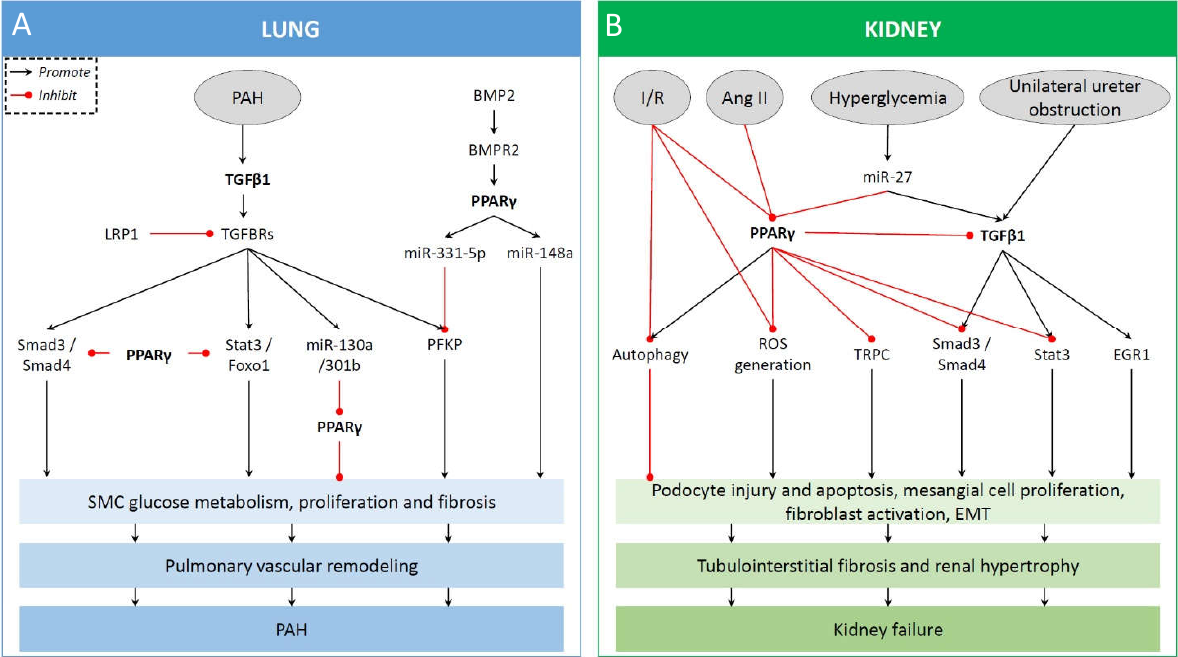
Figure 2. Summary of PPAR γ actions in pulmonary arterial hypertension ( A ) and kidney disease models ( B ).